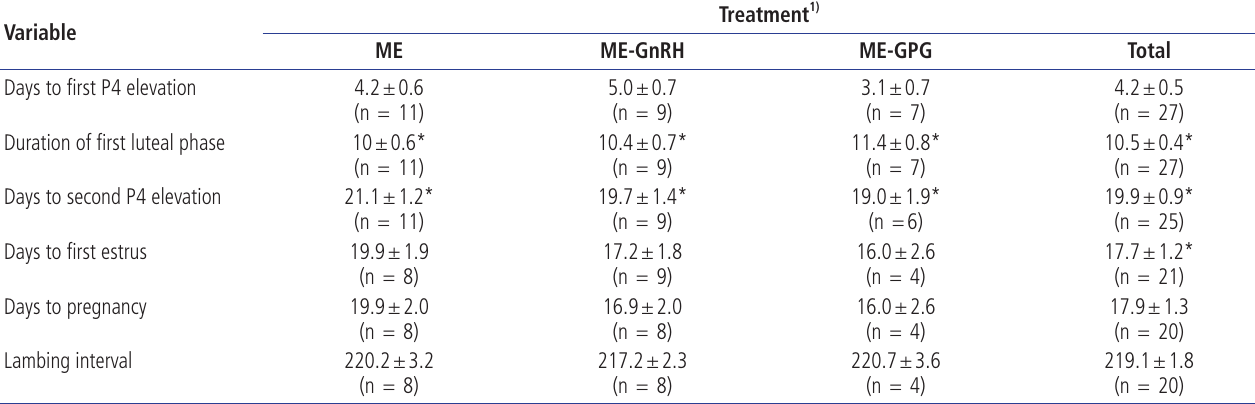
Table 7. Intervals to the first and second elevations of progesterone (P4), duration of the first luteal phase, intervals to estrus and to pregnancy and interval between lambing in the ewes of each group that began their response to treatments with a normal-length luteal phase Variable